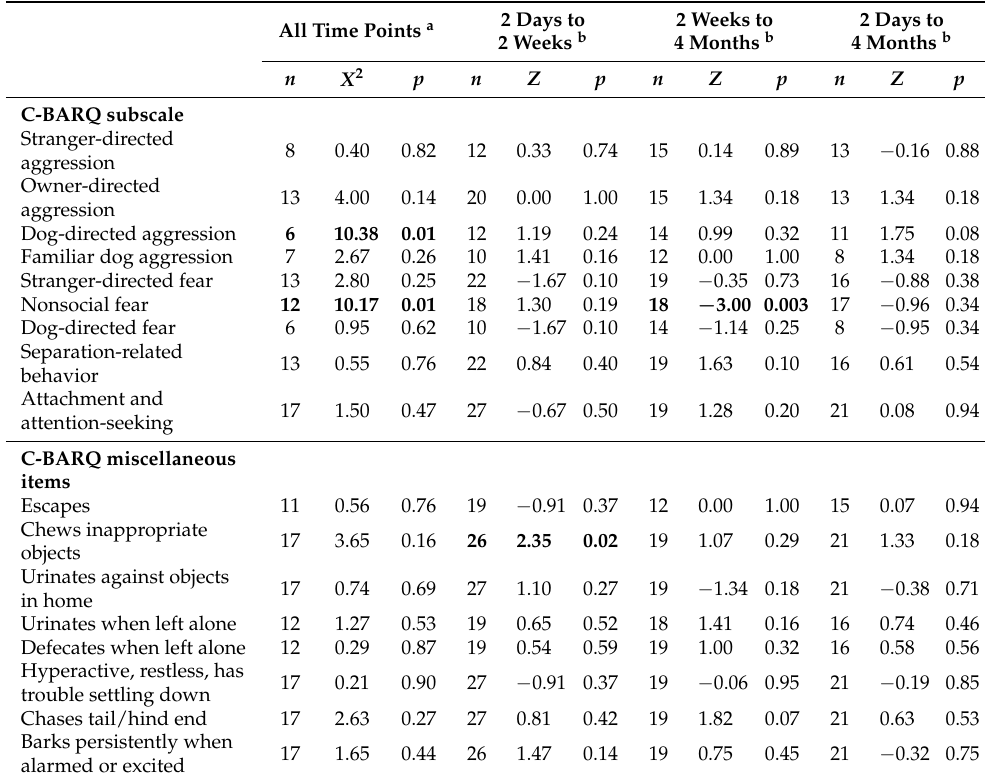
Table 6. Non-parametric tests showing change in non-normally distributed C-BARQ subscales and miscellaneous items following